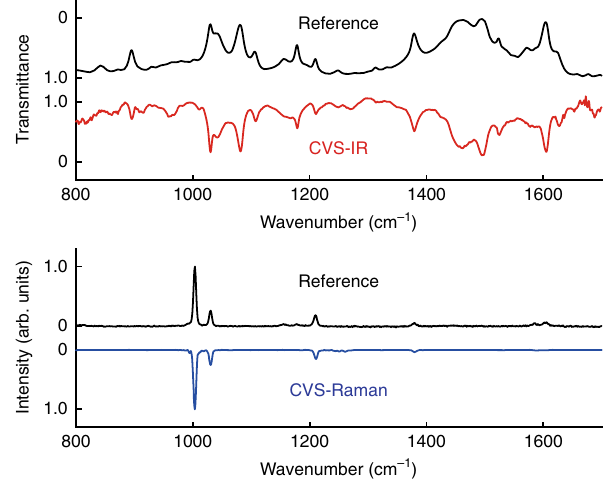
Fig. 3 Complementary vibrational spectra of toluene in the fi ngerprint region. The upper panel shows the comparison of the CVS-IR spectrum and the reference IR absorption spectrum measured by a standard FT-IR. The lower panel shows the comparison of the CVS-Raman spectrum and the